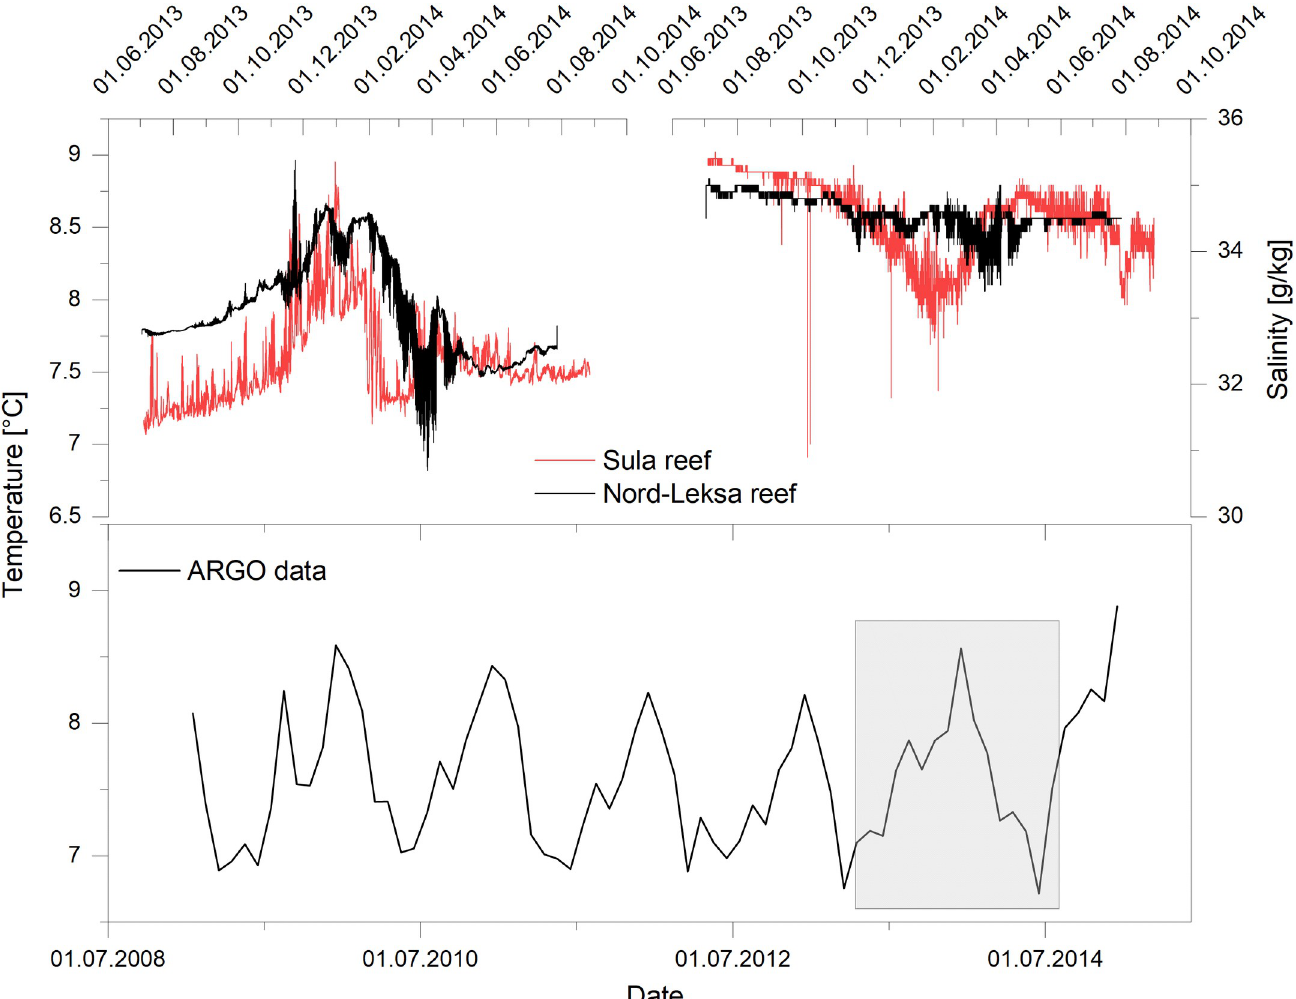
Fig 3. Environmental data gathered by two landers and ARGO data. A) Temperature. B) Salinity. C) ARGO Temperature data. The grey box gives the timeframe of the lander